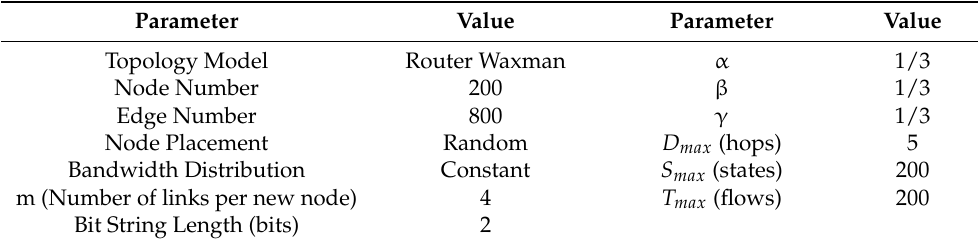
Table 1. Evaluation settings.